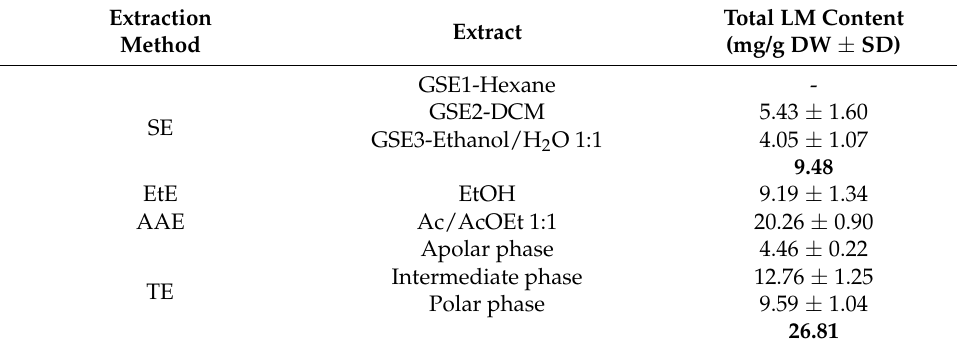
Table 1. Content of main limonoids (limonin and nomilin) in the